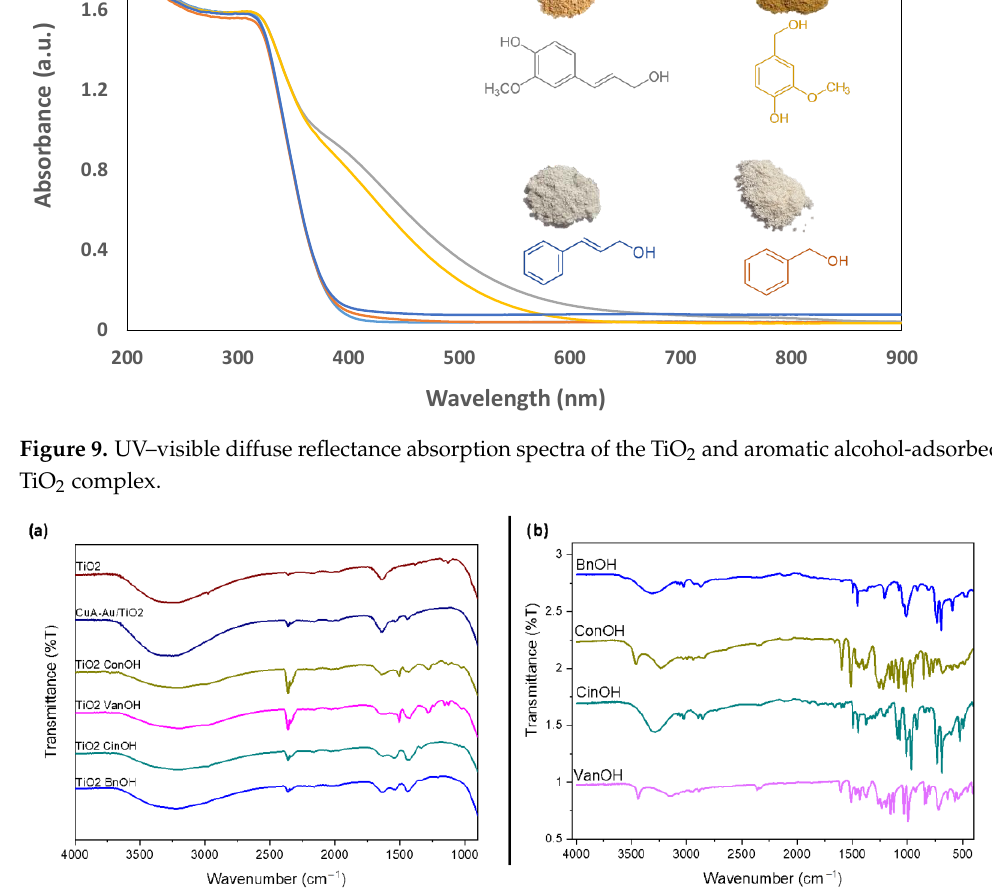
Figure 11. Fourier transform infrared spectroscopy (FTIR) of alcohol-adsorbed TiO 2 ( a ) and aromatic alcohols ( b